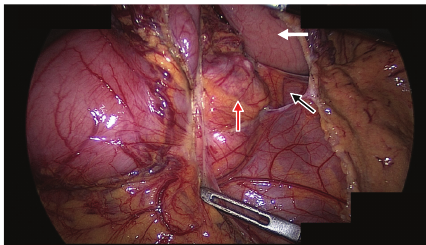
Figure 2: Laparoscopic image of the retroperitoneum as seen through a window created in the gastrocolic omentum. The stomach is elevated (white arrow), and the pancreatic neuroendocrine tumor (red arrow) can be seen with the absence of any pancreatic tissue distal to the tumor (black arrow).